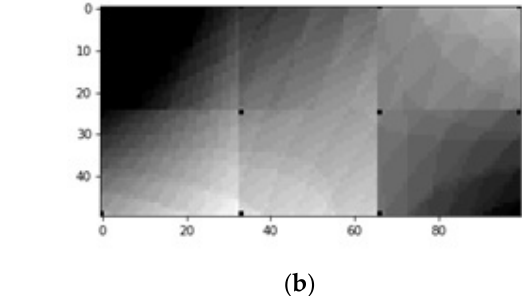
( d ) Figure 5. Part of the training set: ( a ) class none, ( b ) class both, ( c ) class top-left, ( d ) class bottom-right. In the next step, a suitable artificial neural network architecture was chosen: a con- volutional neural network (CNN) was chosen because this architecture recognizes the pat- terns that exist in the images very well [42,43]. Since a CNN is not suitable for implemen- tation in low end wireless nodes, it was planned to be deployed in the middleware layer. Several variants of CNN architectures were tested, some of which contain more than 12,000,000 trainable parameters, so training can be extremely time consuming. However, the goal was that the training does not take long on the average hardware/software plat- form to allow for possible retraining, which would improve the system. Certainly, it is desirable to measure the duration of the training process in hours instead of days. It was